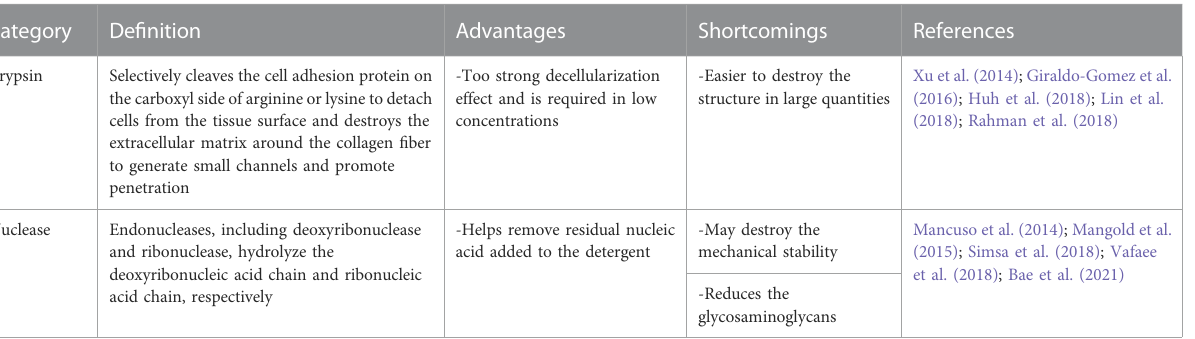
TABLE 5 List of enzymes used for